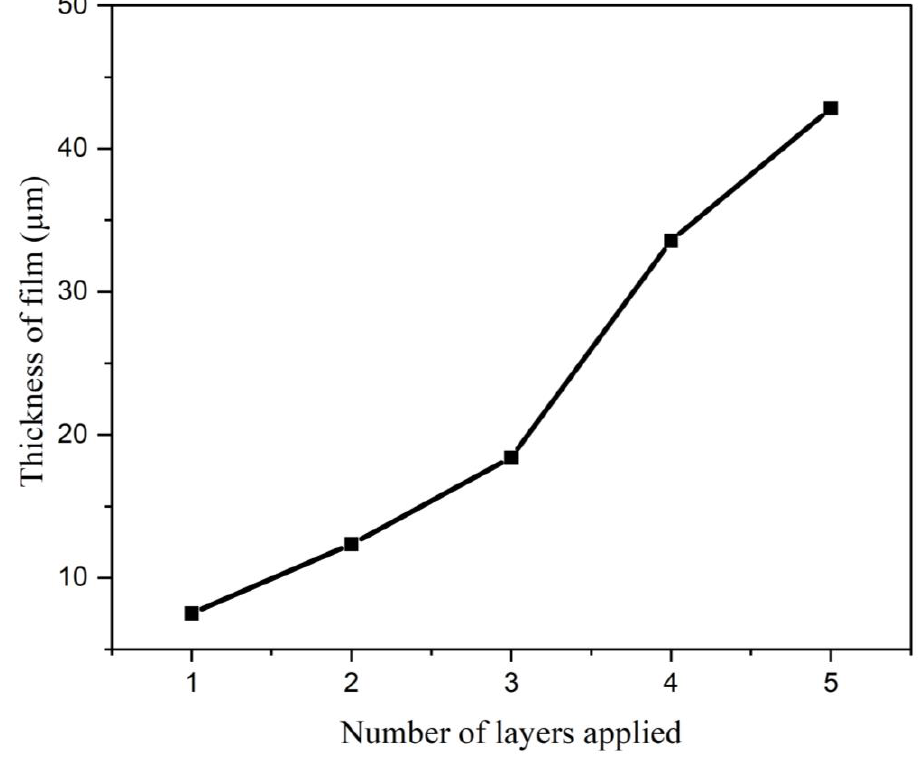
Figure 5. Number of layers of ZnO film applied vs. the thickness of the ZnO film.